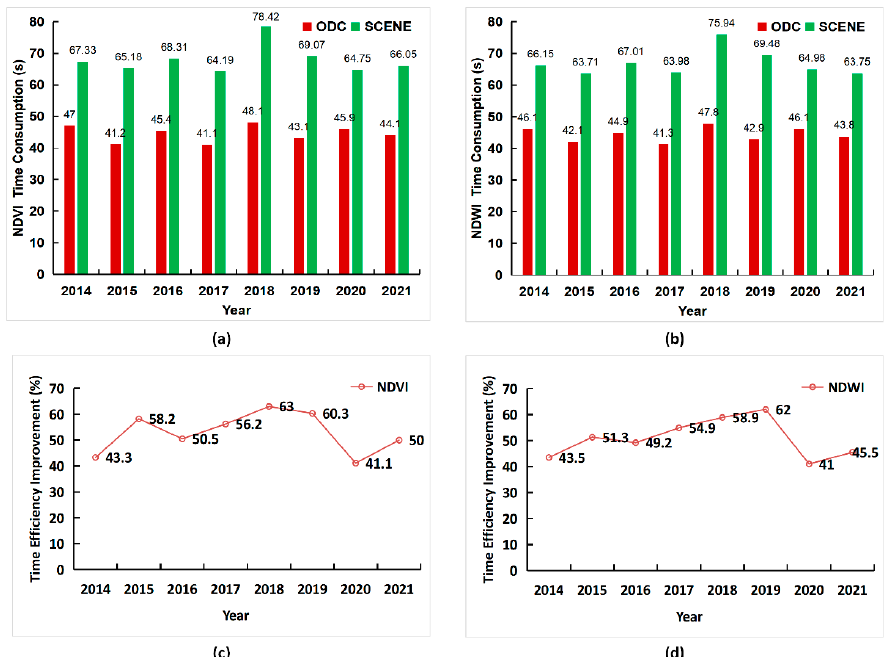
Figure 5. ODC grid-based and scene-based approaches processing time consumption and time effi- ciency improvement. ( a ) NDVI calculating time consumption (s) based on ODC grid-based ap- proaches (red bars) and scene-based approaches (green bars). ( b ) NDWI calculating time consump- tion (s) based on ODC grid-based approaches (red bars) and scene-based approaches (green bars). ( c , d ) Time efficiency improvement percentage (%) of the ODC grid-based approach over the scene- based approach for calculating NDVI and NDWI, respectively.